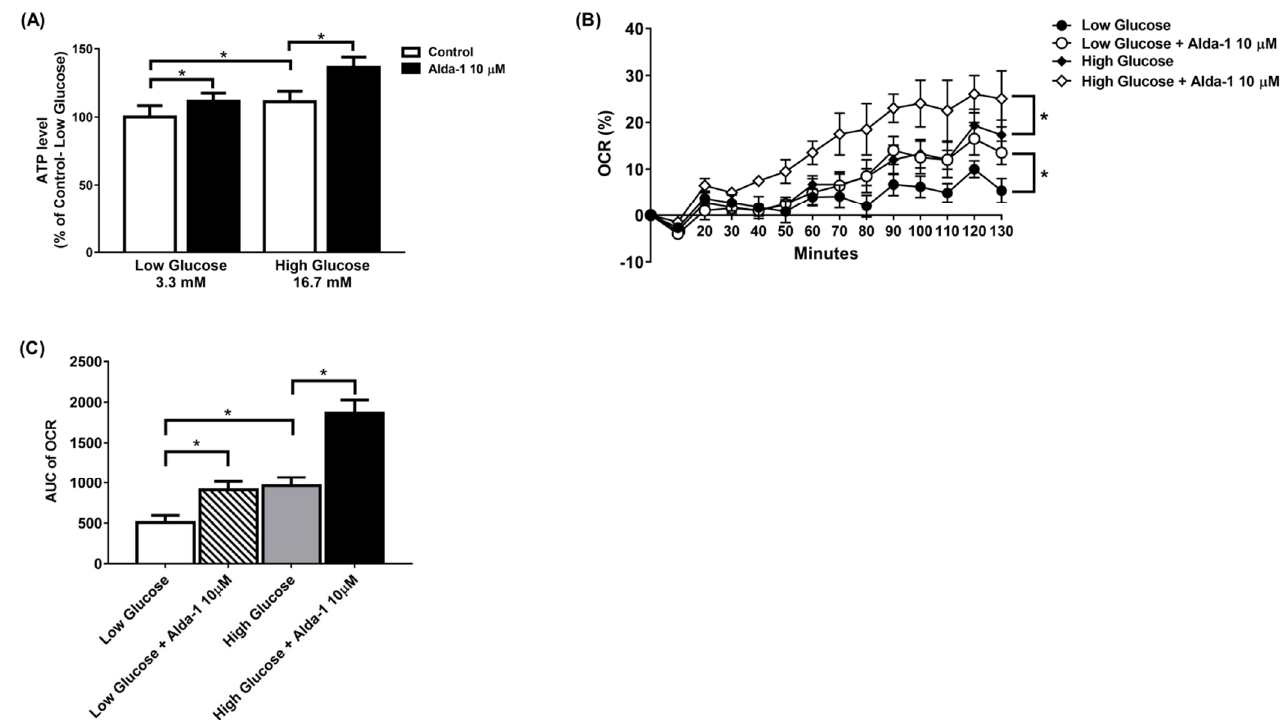
Figure 2. Alda-1 improves mitochondrial function. ( A ) ATP level in response to 10 μM Alda-1 in MIN6 cells under low (3.3 mM) and high glucose (16.7 mM) concentrations. ( B ) Effect of Alda-1 on oxygen consumption rate (OCR) in MIN6 beta cells under low (3.3 mM) and high glucose (16.7 mM) concentrations. ( C ) The area under curves (AUC) of the OCR. Data are presented as mean ± SEM of three independent experiments ( n = 3 per group). * p < 0.05 versus the control group with p -for-trend analysis and Student’s t -test, respectively.